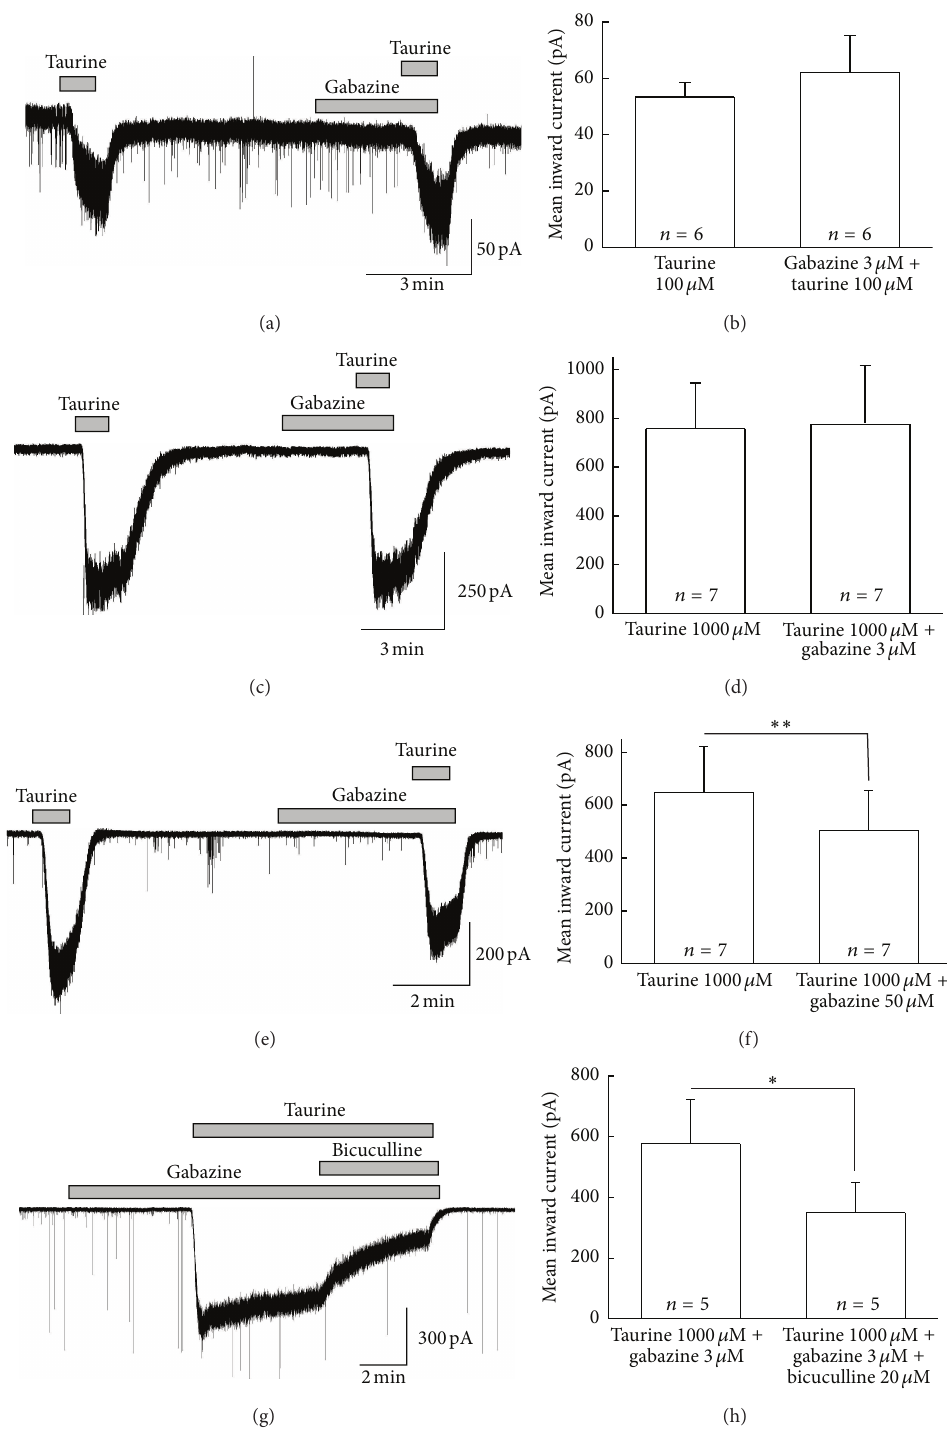
Figure 5: Taurine-induced inward current is only sensitive to gabazine at high concentration on SG neurons. (a), (c), (e) The representative traces showing the responses to taurine (100 𝜇 M and 1,000 𝜇 M) were not affected by gabazine 3 𝜇 M but were affected by gabazine 50 𝜇 M. (b), (d), (f) Bar graphs showing no significant difference about mean inward currents between the application taurine alone and taurine in the presenceofgabazine3 𝜇 M( 𝑃 > 0.05 ),buttherewasaconsiderablechangeinthepresenceofgabazine50 𝜇 M( 𝑃 < 0.01 ).(g)Therepresentative trace showing the inhibition of taurine-induced inward current in the presence of gabazine by GABA A broad antagonist bicuculline (20 𝜇 M). (h) The bar graph showing the mean inward current induced by taurine 1,000 𝜇 M in the presence of gabazine 3 𝜇 M and the mean remaining response after being blocked by bicuculline 20 𝜇 M ( 𝑃 < 0.05 ). Holding potential was −